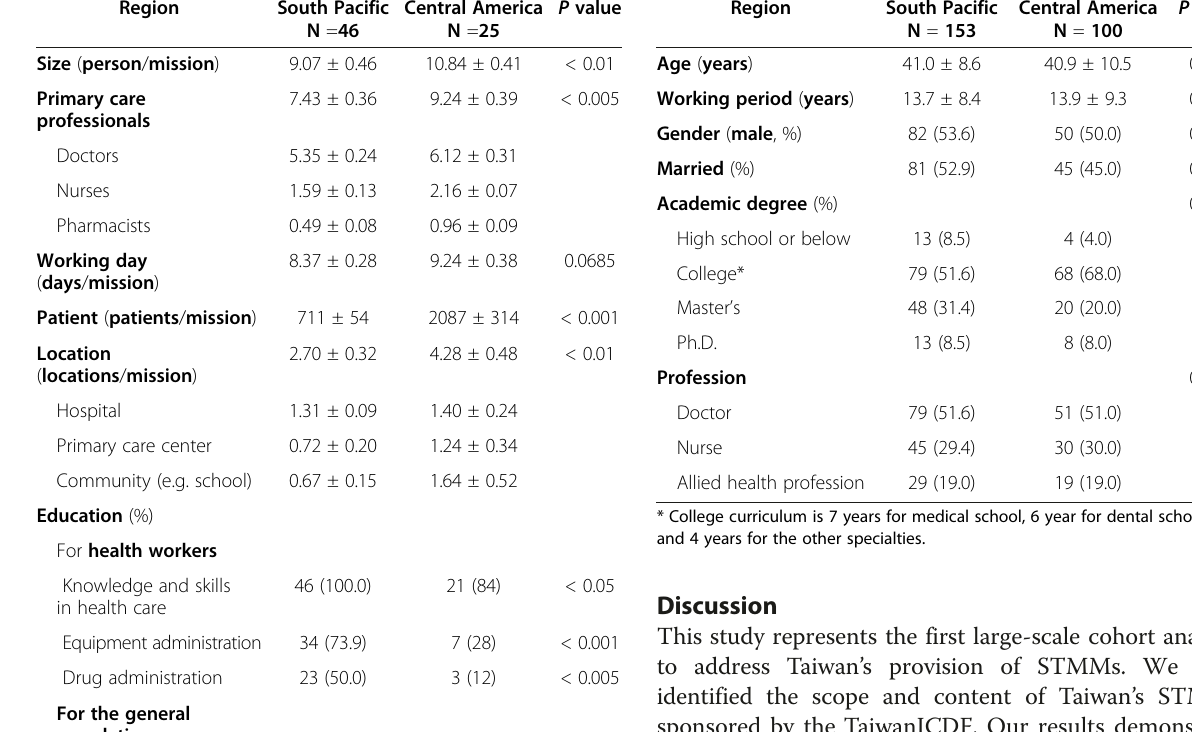
Table 5 Demographic data of 253 health